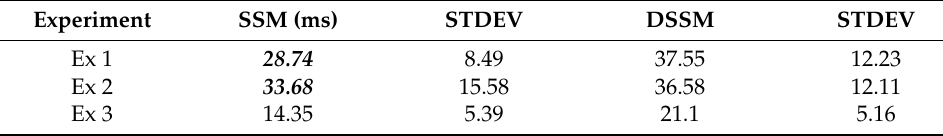
Table 11. Average time of the estimating robot position in